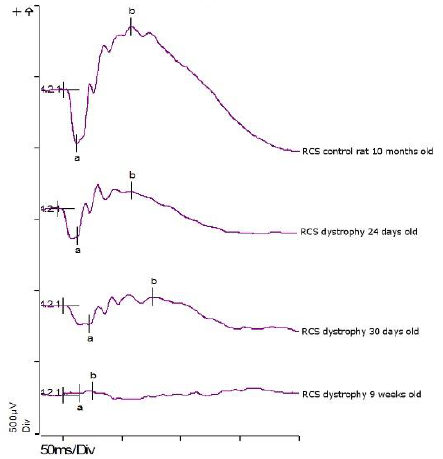
Figure 16. Scotopic 0.5 cd x s / m 2 ERG of Royal College of Surgeons (RCS) control animal at the age of 10 months, RCS dystrophic rat at the age of 24 days, 30 days, and 9 weeks. The progressive photoreceptor degeneration and loss of photoreceptor functionality can be seen as the α and β wave (marked as a and b in the graph) amplitudes decrease in magnitude rather rapidly between 24 and 30 days in the RCS dystrophic rat, whilst the 10-month old RCS control animal exhibits distinct α and β wave responses. The fully blind nine-week-old RCS dystrophy rat has no measurable α or β wave amplitudes.